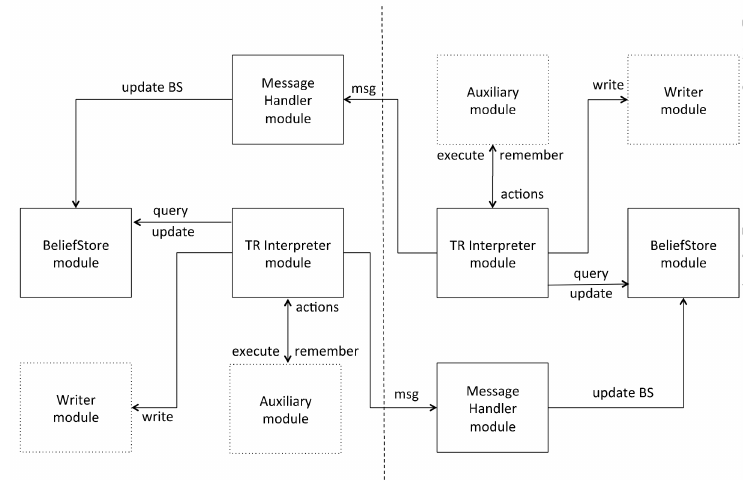
Figure 4. Communications between two TR nodes: modules involved in the